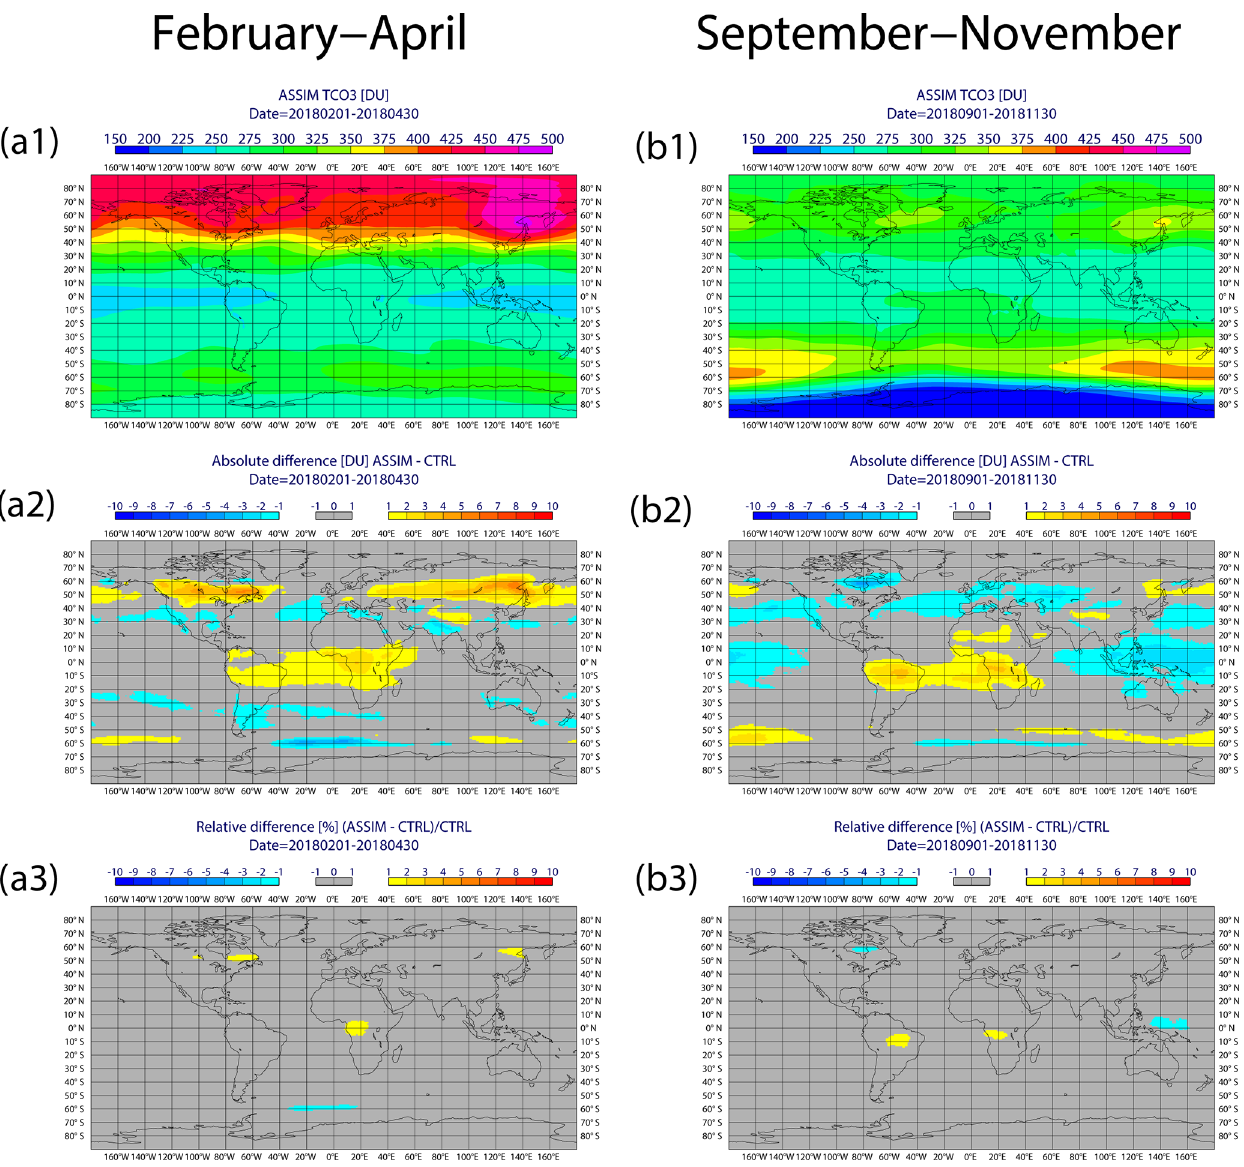
Figure 9. Average fields for (a) FMA and (b) SON 2018. (1) Mean TCO3 analysis from ASSIM, (2) the absolute differences between ASSIM and CTRL in DU and (3) the relative differences between ASSIM and CTRL in